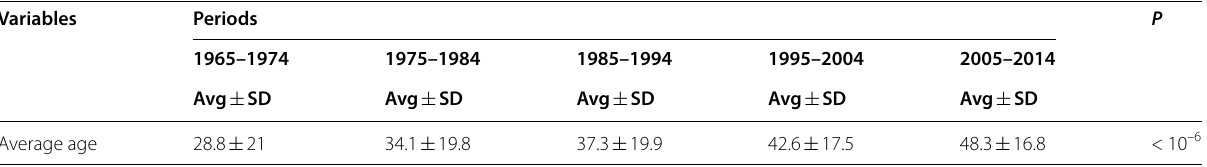
Avg: average, SD: standard deviation